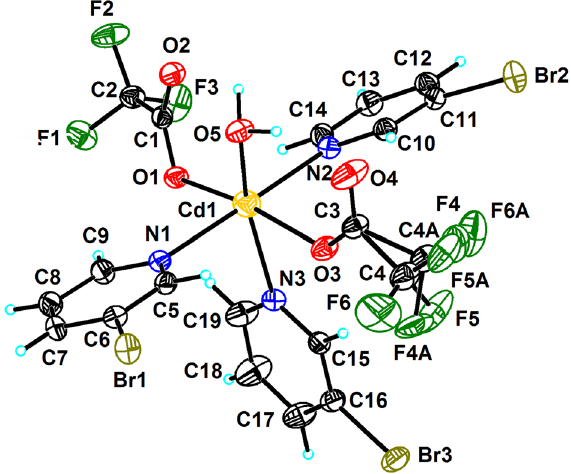
Allreagents were ofanalyticalgradeandusedas purchased.